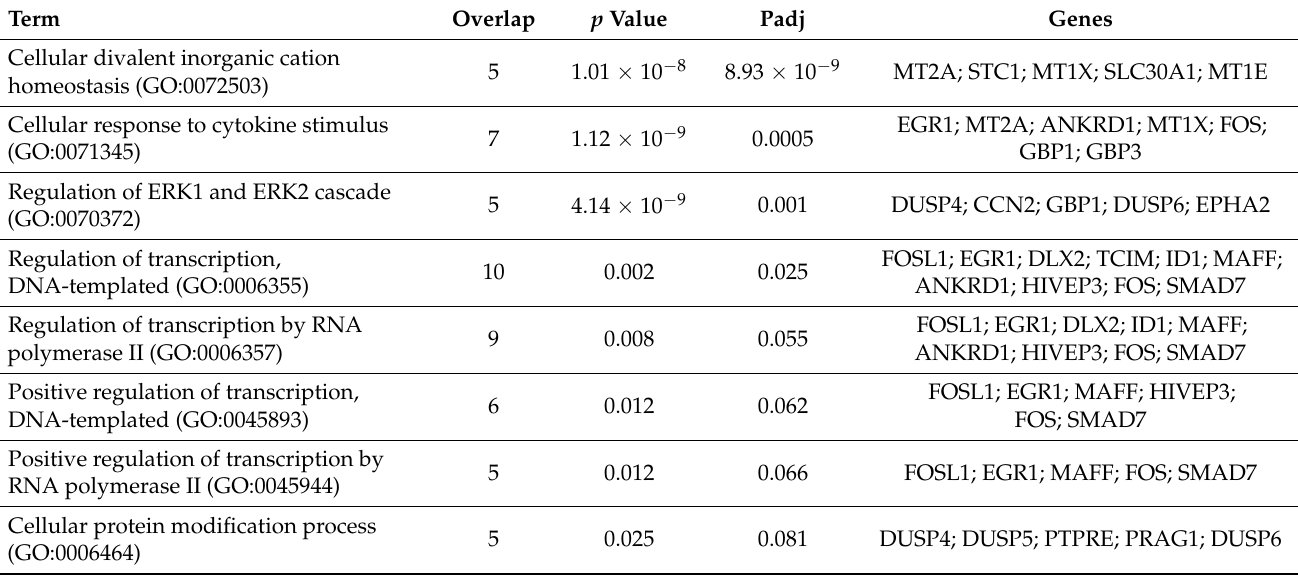
Table 7. Table showing the identified enriched pathways using the 33 downregulated